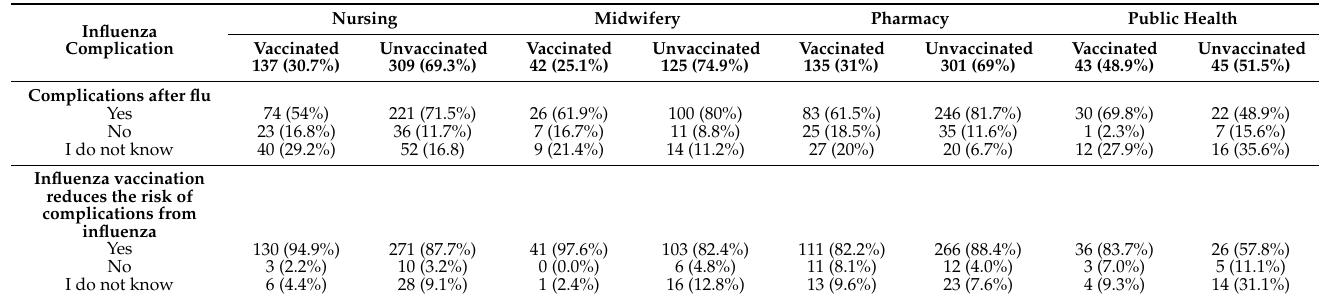
Table 1. Influenza risk assessment and the possibility of reducing risk by vaccination, according to student major.